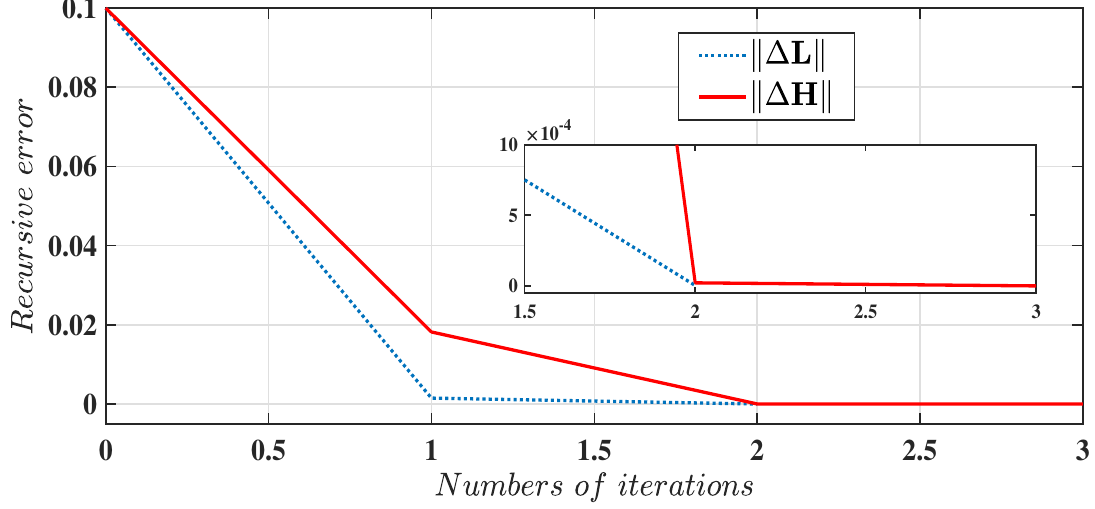
Figure 3. The recursive procedures of solving the transformation matrices L and H